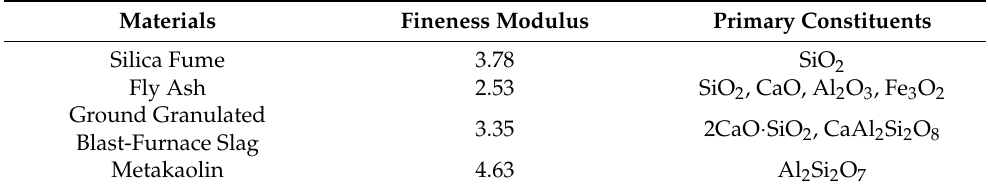
Table 2. Fineness moduli ( F ) and compositions for pozzolans used in this